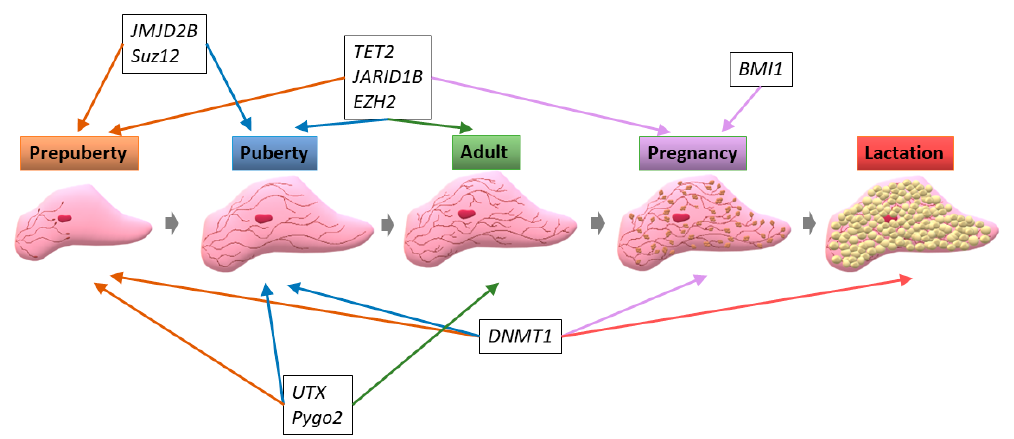
Figure 3. Epigenetic modulating proteins with a role in mammary gland development: Mammary gland development occurs throughout the lifetime and can be divided into several distinct stages some of which are represented here. Multiple proteins, involved in epigenetic regulation and mentioned in the text boxes above, play a role in this development largely through influencing mammary stem cell quiescence and activation, as well as luminal differentiation and lineage commitment. Colour-coded arrows show which stages these proteins modulate.